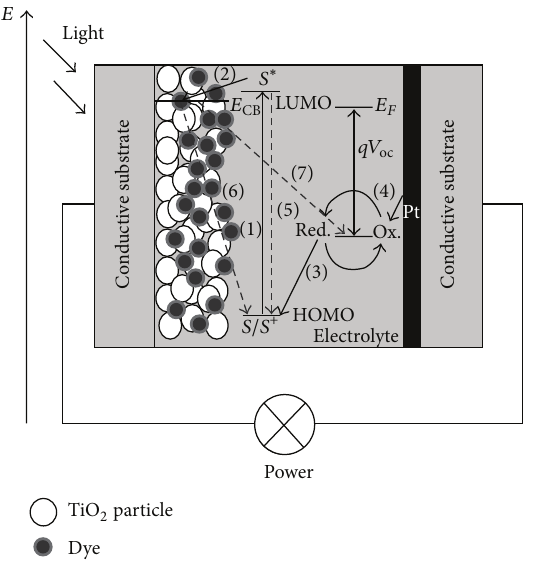
Figure 1: Working principle scheme of the dye-sensitized solar cell